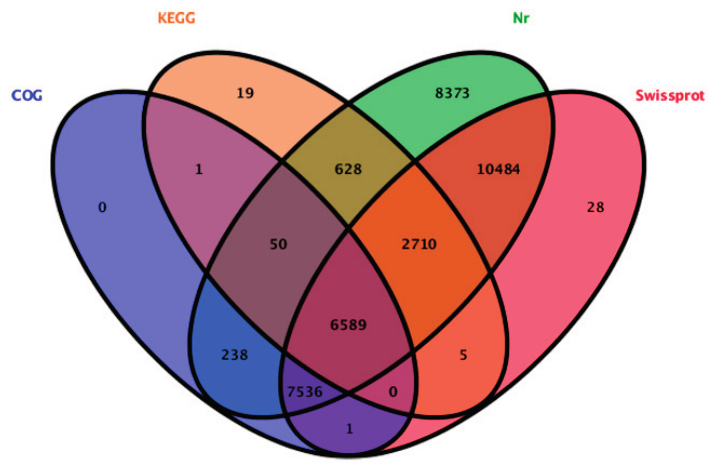
Figure 2. The unigenes showed homology with sequences in the Nr, Swiss-Prot, COG (Clusters of Orthologous Groups of proteins) and KEGG (Kyoto Encyclopedia of Genes and Genomes)